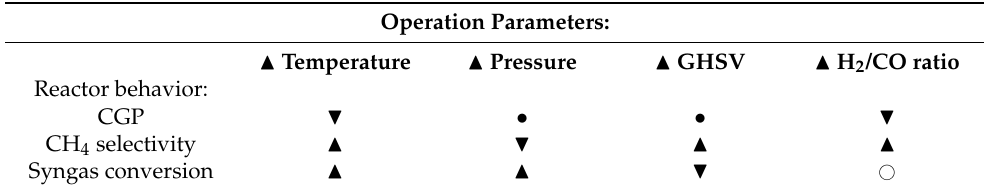
Table 2. Dependencies of the reactor behavior on the main Fischer–Tropsch reactor operation parameters [30,46,50,51] for cobalt-based